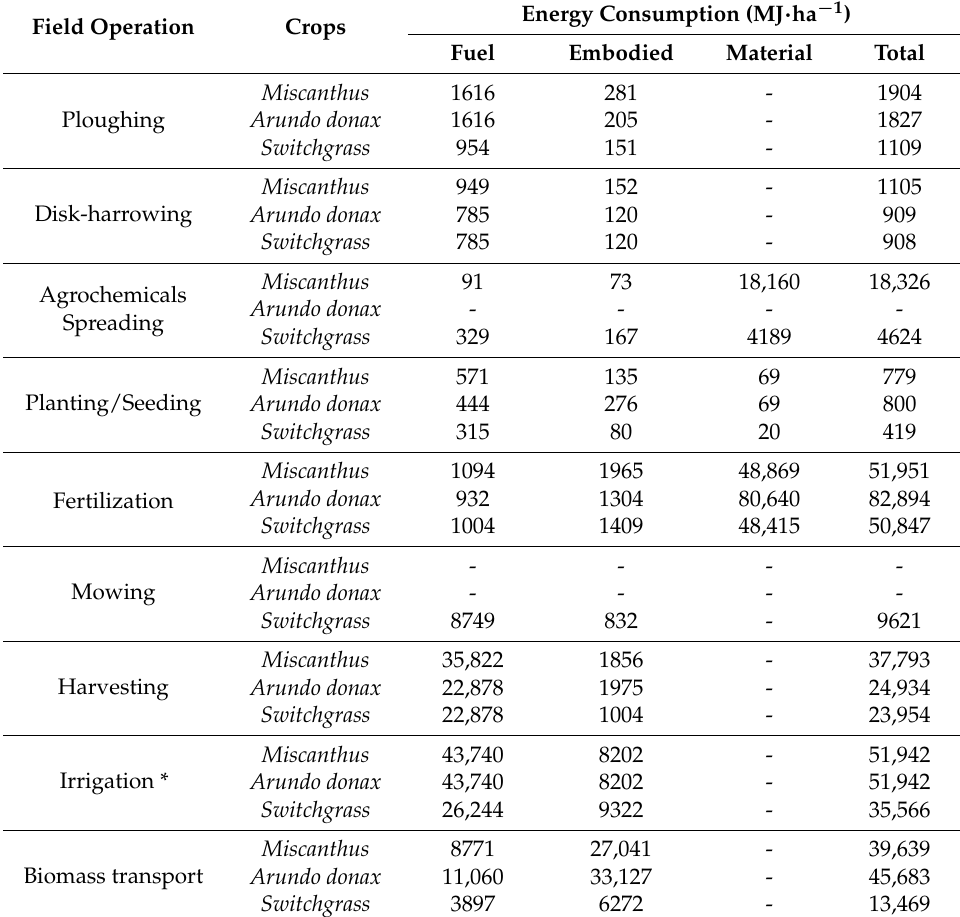
Table 5. Energy consumption per field operation for ten years production